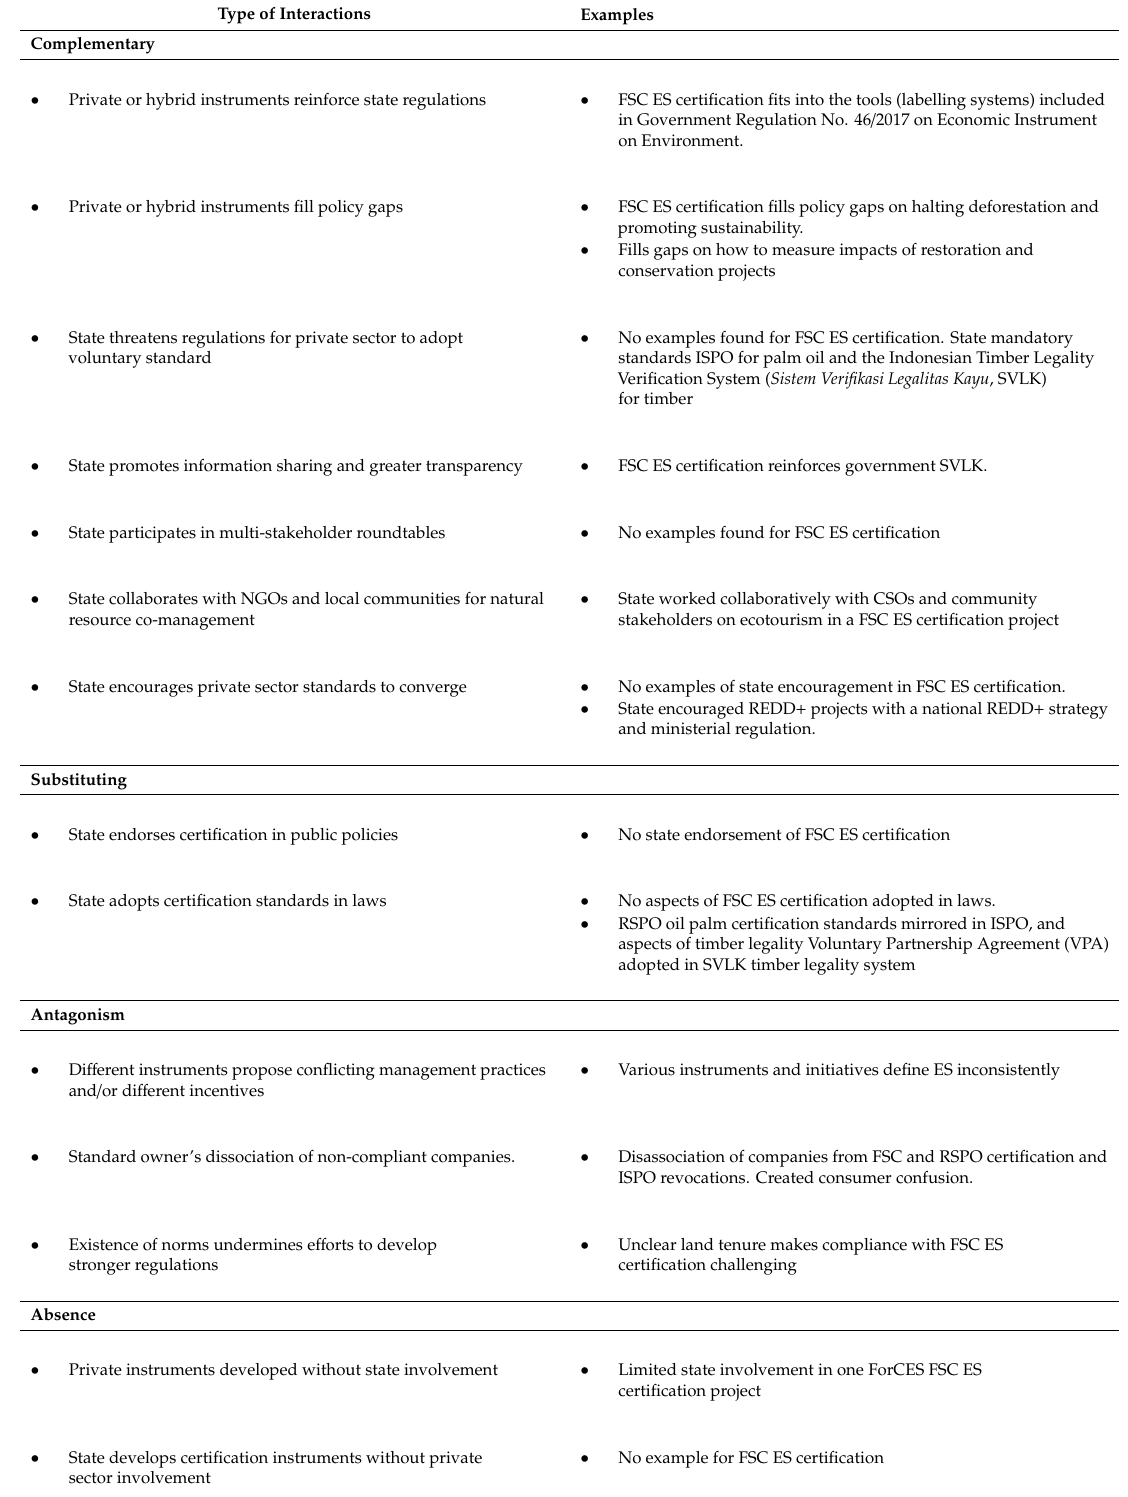
Table 3. Types of interactions in the agenda setting and negotiation phase between state regulations and non-state market driven ecosystem services governance in